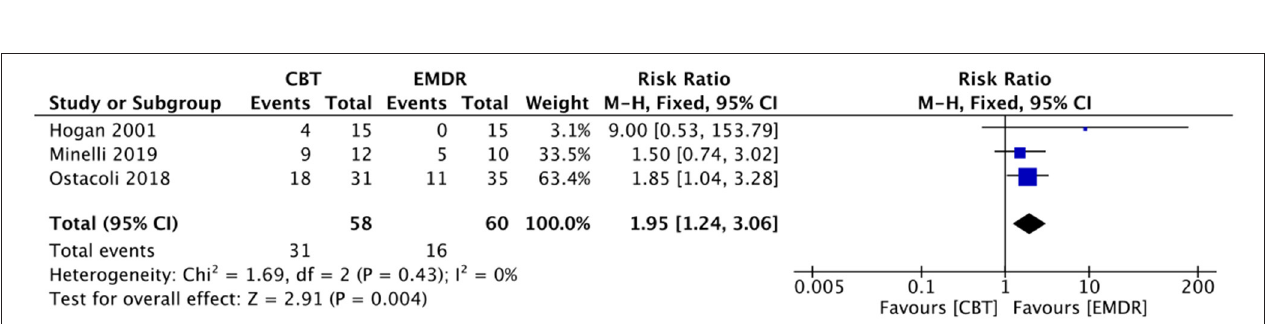
FIGURE 7 | Forest plots of meta-analyses EMDR vs. CBT group on remission. EMDR, eye movement desensitization and reprocessing. CBT, cognitive behavioral